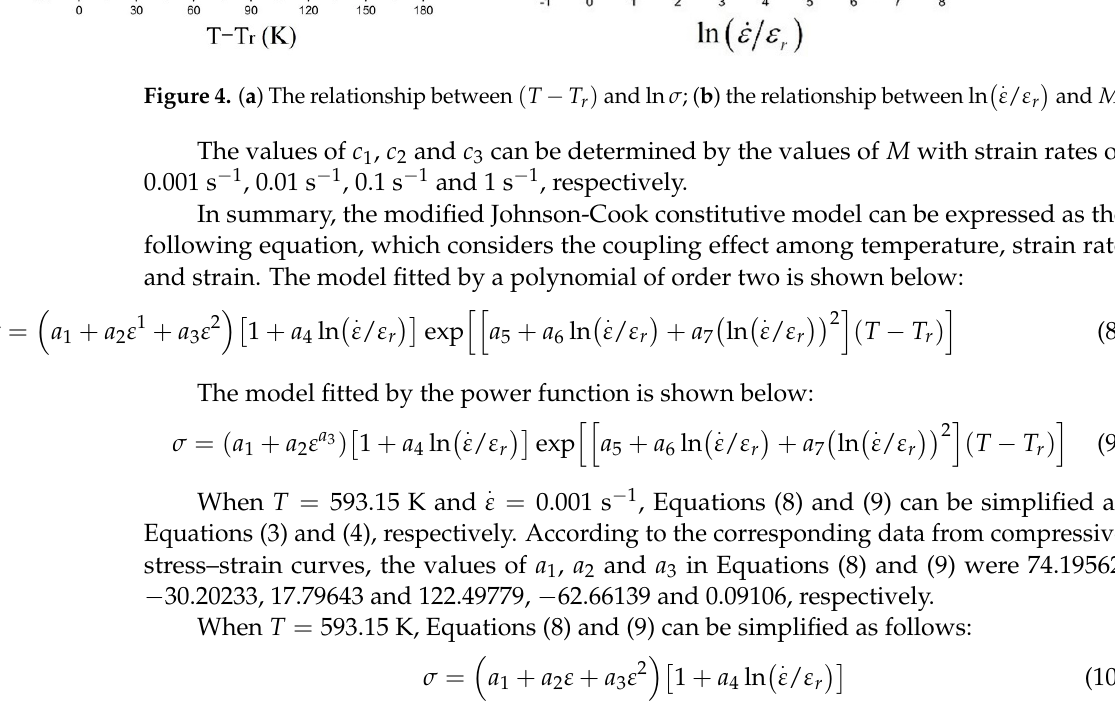
When =593.15 T K and 1 =0.001s ε −  , Equations (8) and (9) can be simplified as Equa- stress–strain curves, the values of 1 − 30.20233, 17.79643 and 122.49779, − 62.66139 and 0.09106, respectively.